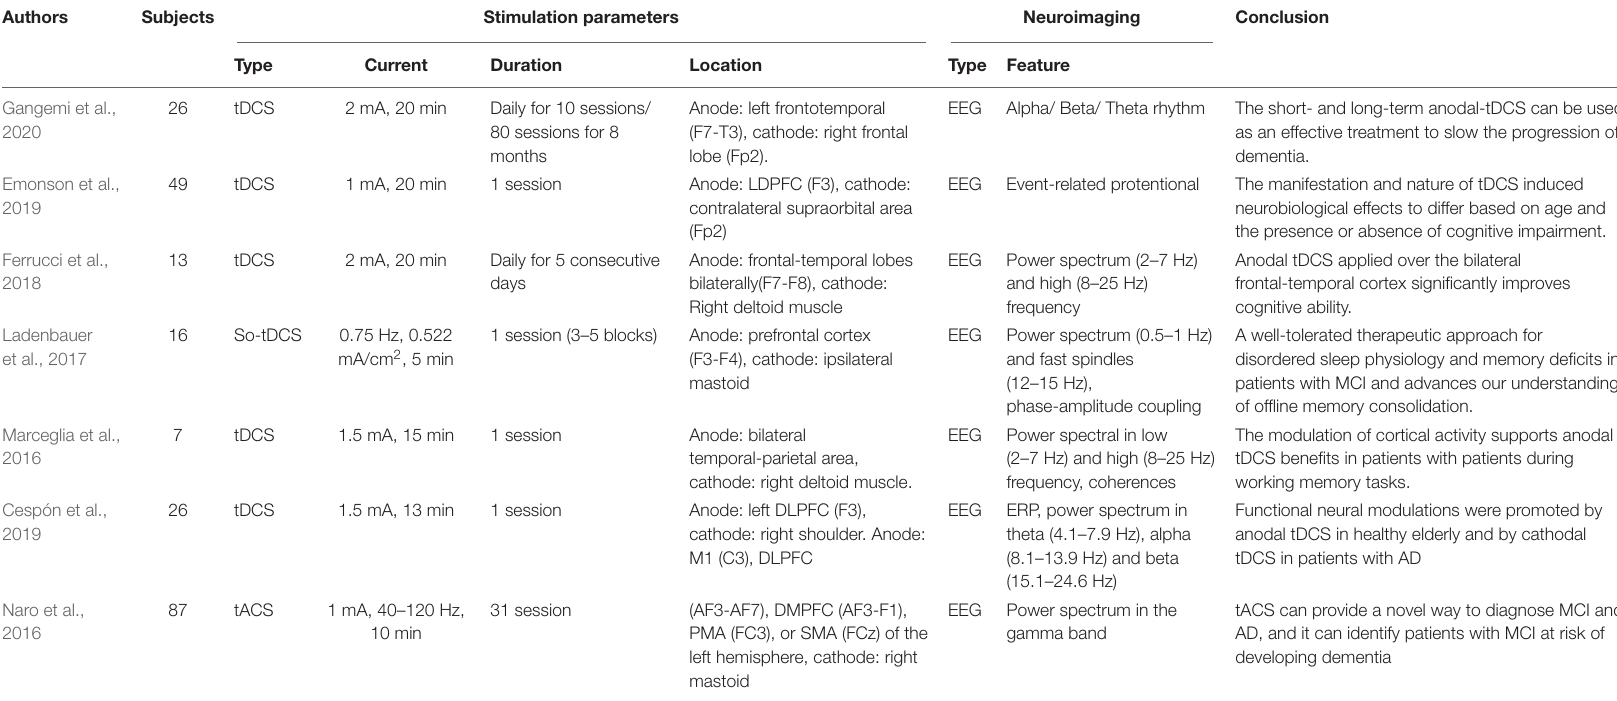
TABLE 1 | Studies and experimental characteristics of tES literature for AD and MCI.